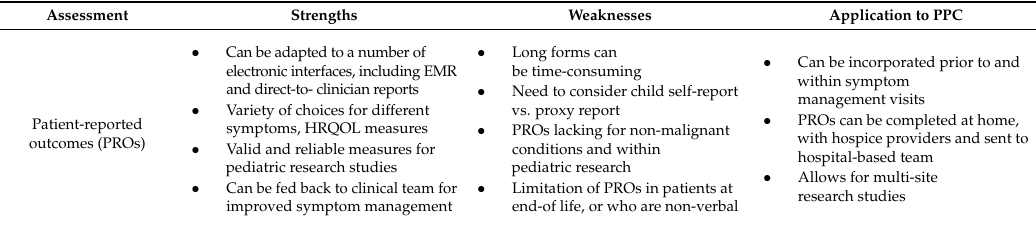
Table 3. Methods of pediatric symptom